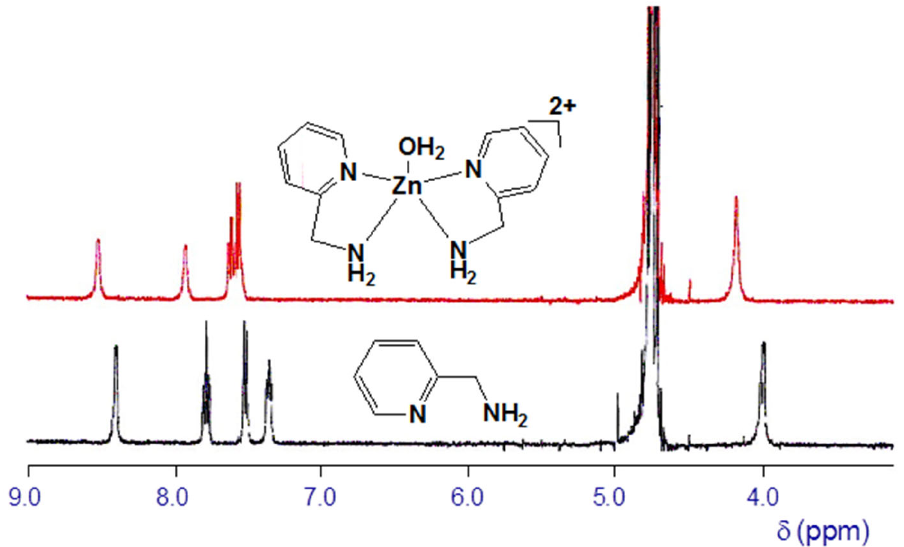
Figure 3. 1 H NMR spectra of the ligand 2 ‐ PA and its zinc(II) complex Zn2 .